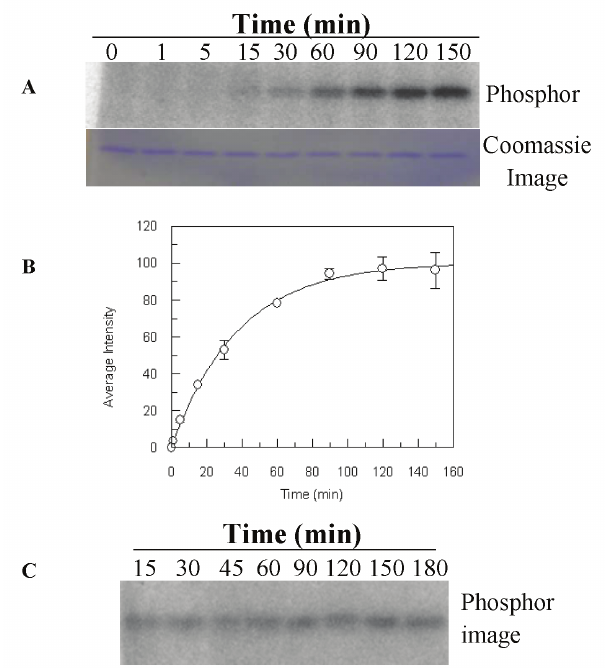
Figure 2. The autokinase activity of His-LytS. ( A ) His-LytS at 5 µM was incubated with [ γ - 32 P]-ATP (100 µM) in PB at room temperature. Reaction was quenched at different time intervals and samples were analyzed by 15% SDS-PAGE. ( B ) Progress curve of His-LytS autophosphorylation. The quantified band intensities of phosphorylation were plotted against time. The data were fitted using Origin software to pseudo first order equation (1) to calculate the rate constant. Errors are the standard deviation from two independent trials (Dataset 1). ( C ) Stability of the phosphorylated His-LytS species. His-LytS at 5 µM was phosphorylated for 90 min in PB buffer (50 mM Tris, pH 7.4, 5 mM MgCl ) at room temperature. 2 Excessive ATP was removed by desalting and stability was monitored over 3 hours at different time intervals. Samples were analyzed by 15% SDS-PAGE. All gels were exposed to phosphor-screen (GE Healthcare) overnight and imaged using a Typhoon Trio + imager (GE Healthcare). The gel in panel ( A ) was also stained with Coomassie blue to view the protein